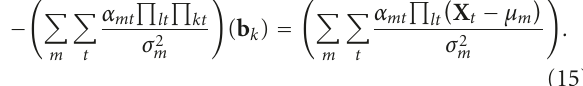
Figure 4: Training.